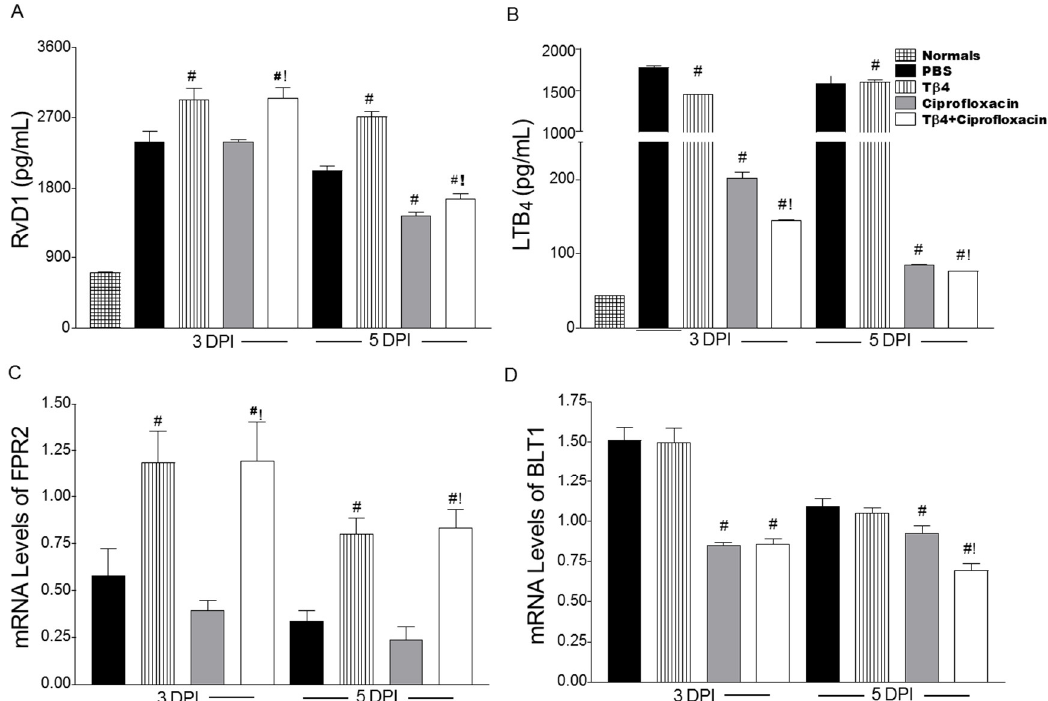
Figure 9. Quantification of RvD1 ( A ) and LTB4 ( B ) and mRNA expression levels for FPR2 ( C ) and BLT1 ( D ) as detected in corneas of PBS-, T β 4-, ciprofloxacin-, and T β 4 + ciprofloxacin-treated B6 mice at 3 and 5 days p.i. and normal, uninfected controls (protein analysis only). Protein results are reported as mean (pg/mL) ± SEM. N = 5 corneas/group/time point. mRNA expression levels are represented as relative fold change for the gene of interest compared to β -actin ± SEM. N = 8 corneas/group/time point. # P < 0.05 versus PBS; ! P < 0.05 versus ciprofloxacin.